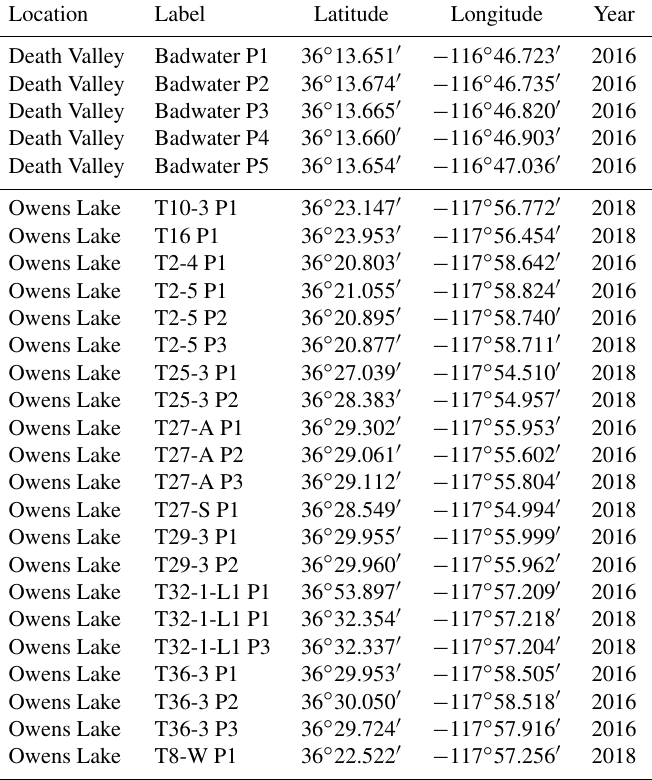
Table 1. Location, site label, GPS coordinates, and year of data collection for sites at Badwater Basin (Death Valley, CA) and Owens Lake (Owens Valley,